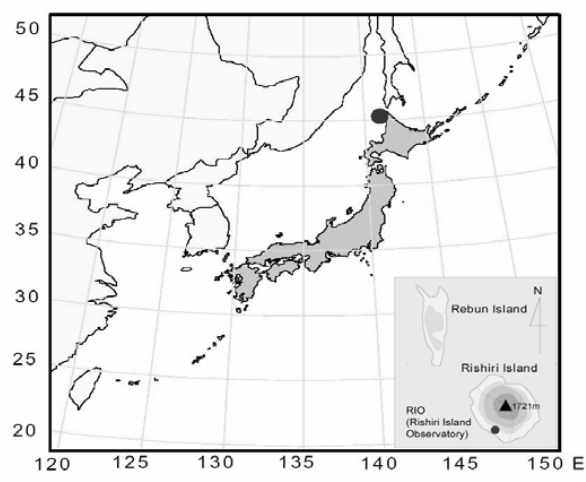
Fig. 1. Geographical location of Rishiri Island and Rishiri Island Observatory.